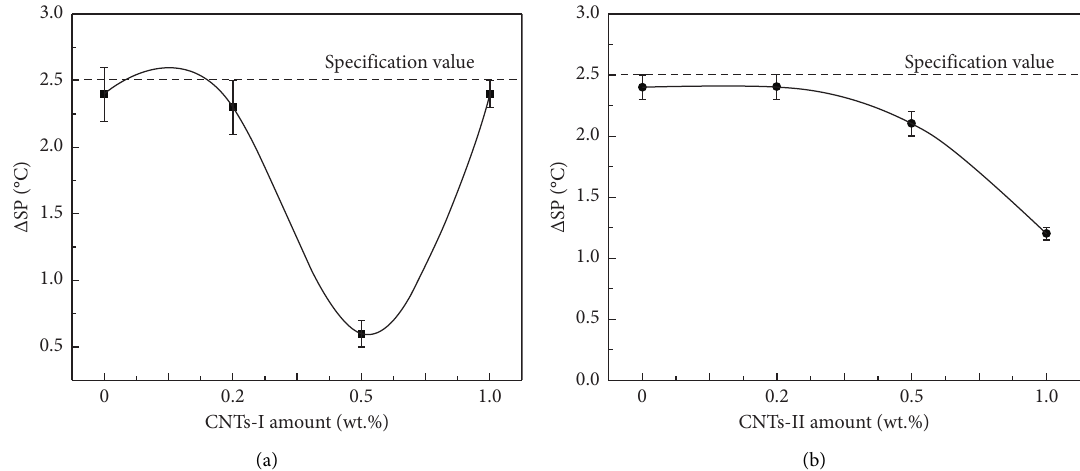
Figure 5: Effect of different amounts of CNTs on △ SP after 2 days of segregation. (a) △ SP changes of CNTs-I. (b) △ SP changes of CNTs-II.